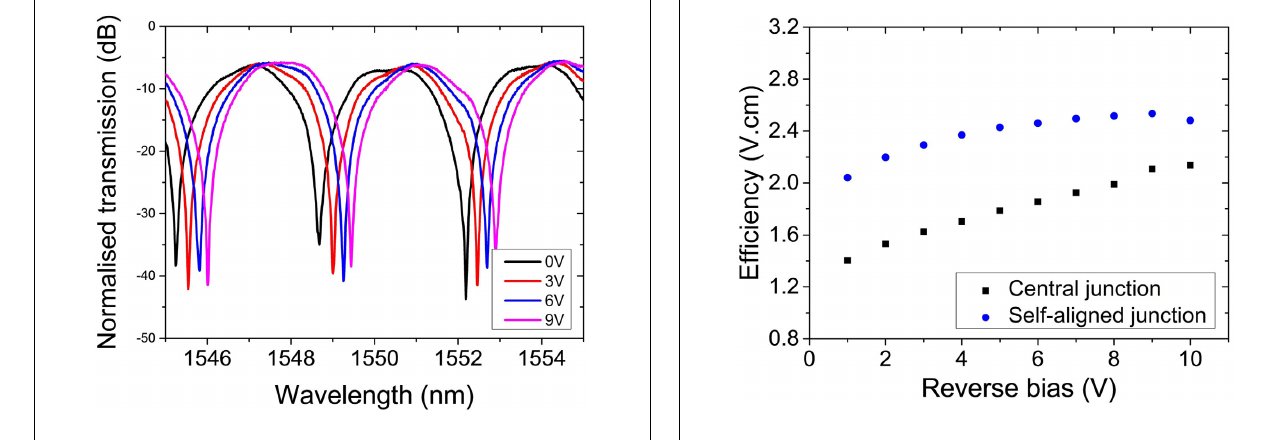
FIGURE 2 | Normalized transmission spectra from a Mach-Zehnder device with 1mm phase modulators with 0, 3, 6, and 9V reverse bias voltages applied.